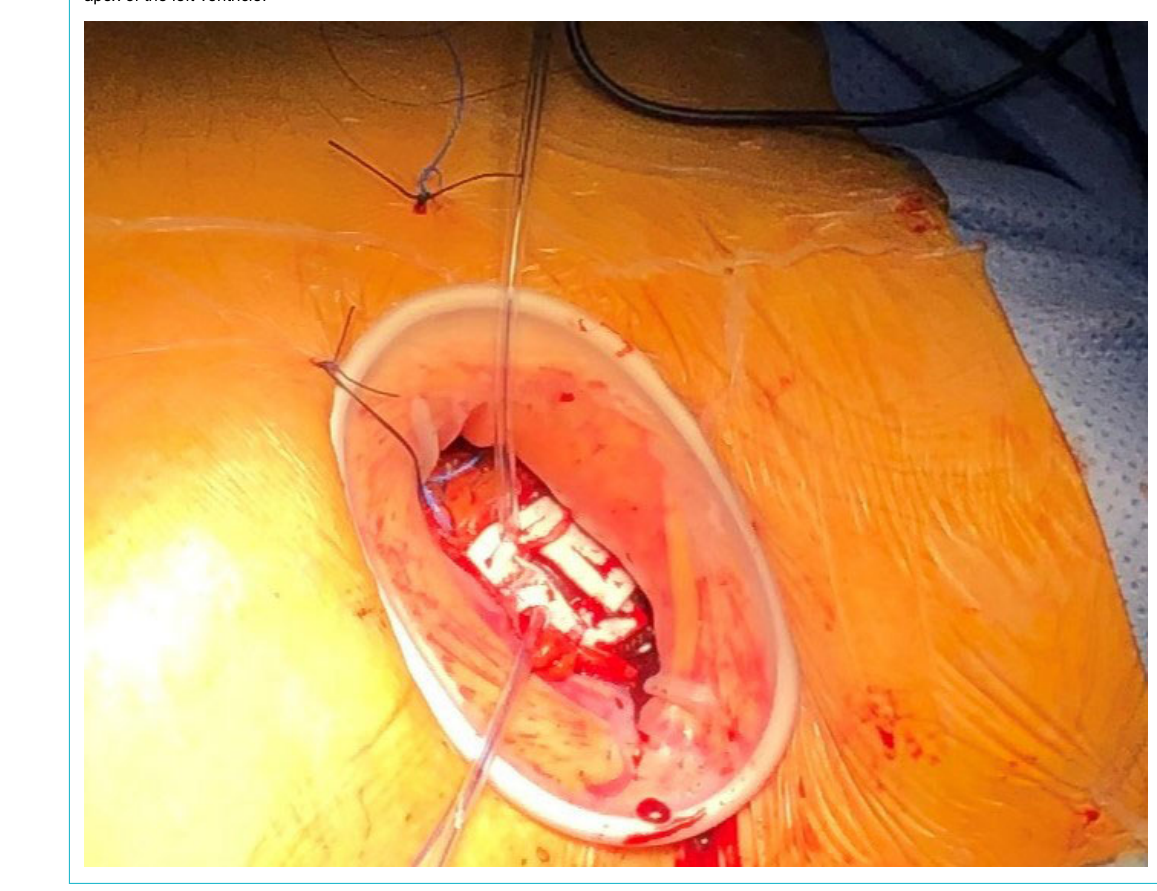
Figure 2: Left anterolateral thoracotomy under the left breast after incision of the pericardium and placement of purse string sutures on the apex of the left